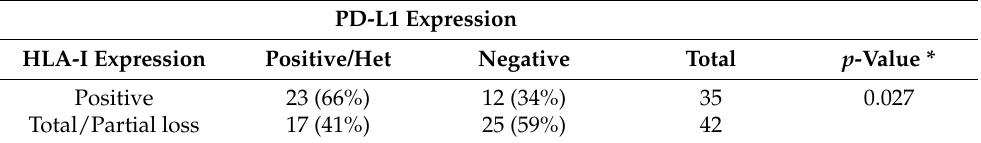
Figure 1. Two examples of tumor immunohistochemistry with different patterns of the expression of HLA class I and PDL-1, and CD8 T-cell infiltration. ( A ) tumor with a HLA-B loss and peritumoral stromal T-cell location (T-cell exclusion pattern); tumor is negative for PD-L1, although there are few positive cells at the tumor margin. ( B ) HLA-I positive tumor (only HLA-B staining is shown) showing intratumoral infiltration with CD8+ T- cells and a homogeneously positive expression of tumor PD-L1. All images are at 100 × magnification. Table 2. Correlation between HLA-I and PD-L1